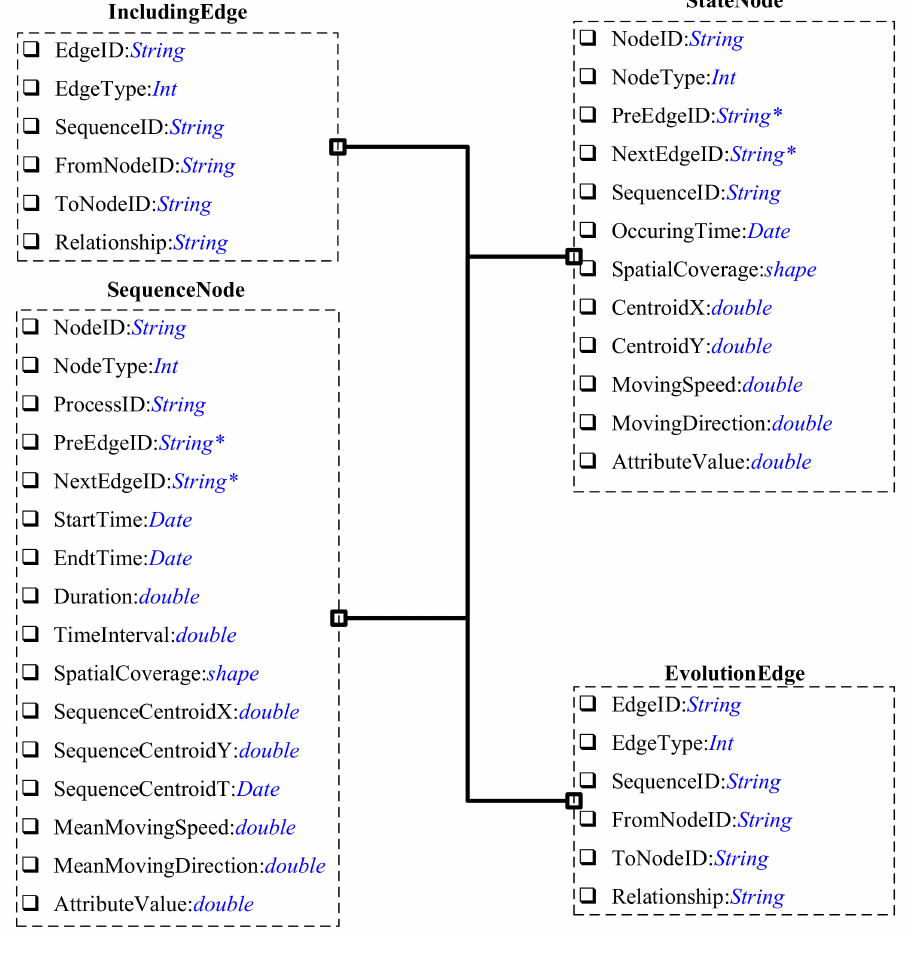
Figure 7. The storage of a sequence graph A: The sequence is linked by NodeID and EdgeID